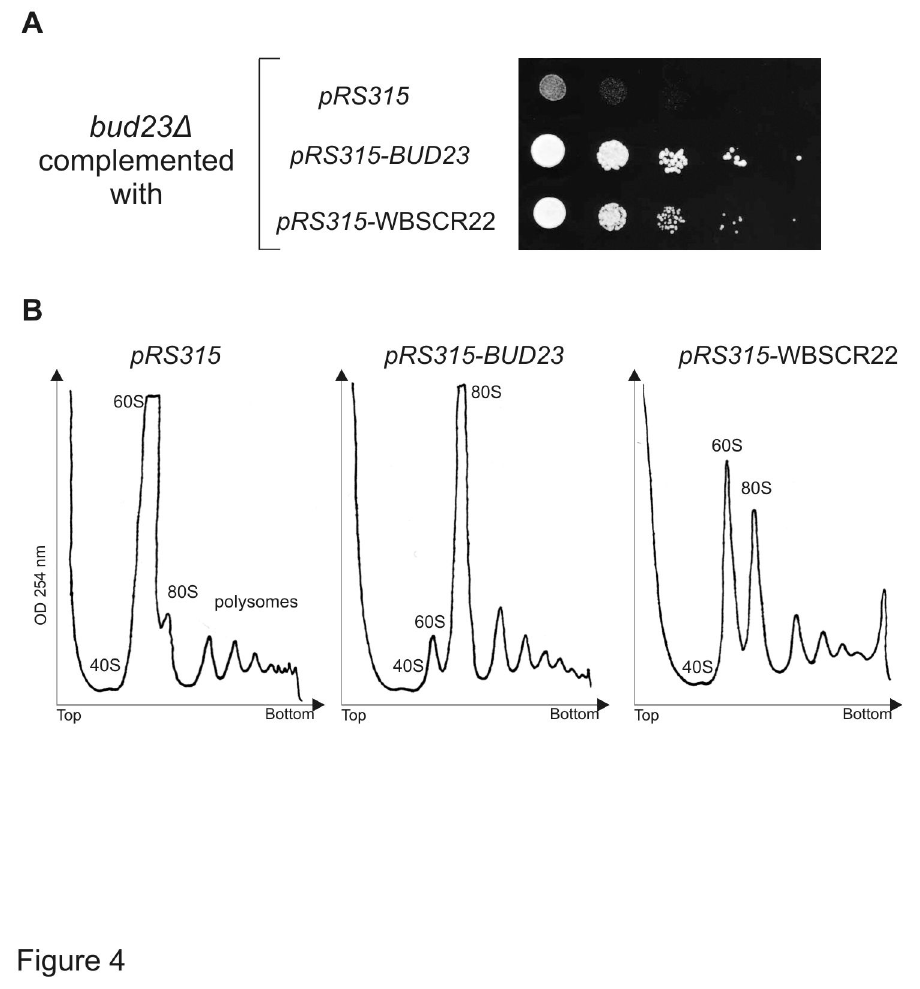
Figure 4. Complementation of yeast bud23Δ strain with human WBSCR22. (A) Growth dilution assays of bud23Δ carrying plasmids pRS315 , pRS315-BUD23 and pRS315 -WBSCR22. Cultures were grown overnight and diluted to final optical density at OD 0.1, from which further 10-fold serial dilutions were spotted. Plates were incubated at 30°C for 3 days. (B) Polysome profiles 600 of bud23Δ carrying plasmids pRS315 , pRS315-BUD23 and pRS315 -WBSCR22. Cell lysates were centrifuged on 10-45% sucrose gradient. Absorbance at 254 nm was measured across the gradient, and the positions corresponding to the 40S, 60S and 80S ribosomal particles are